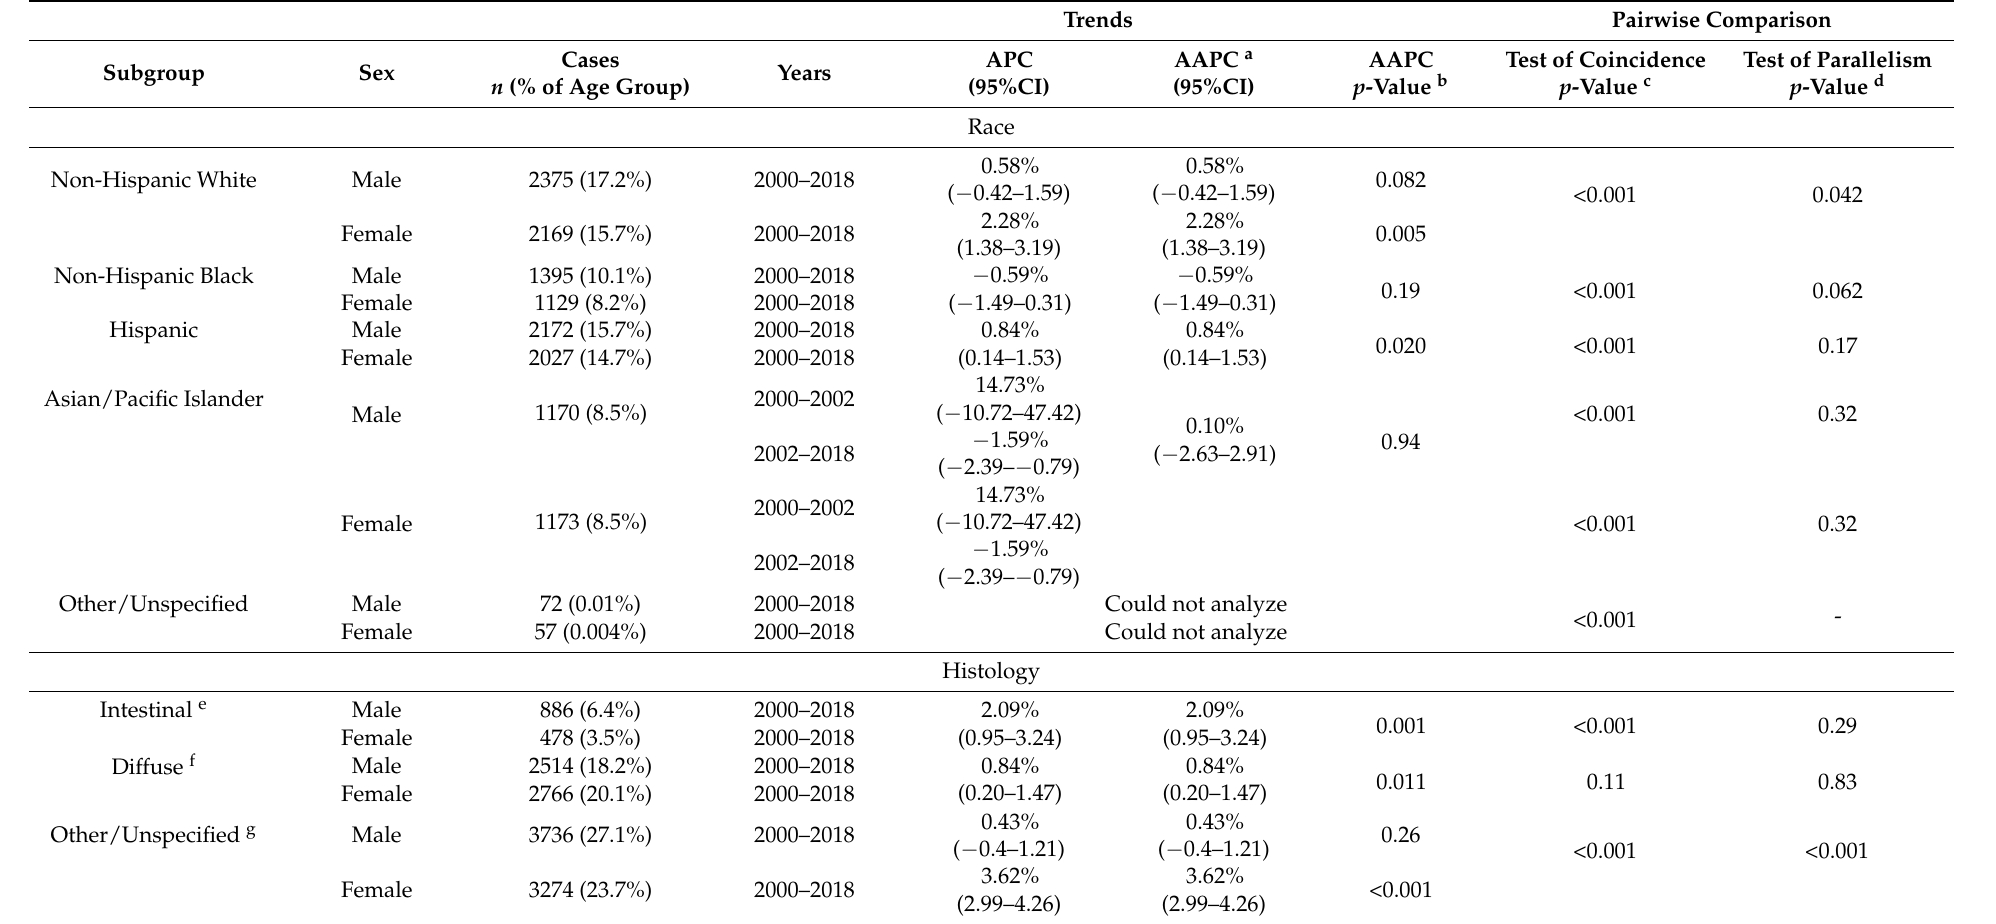
Table 3. Age and Sex-Specific Trends of Non-cardia Gastric Cancer Among Race and Histology Subgroups in Those of Ages < 55 Years, SEER Database 2000–2018 ( N =